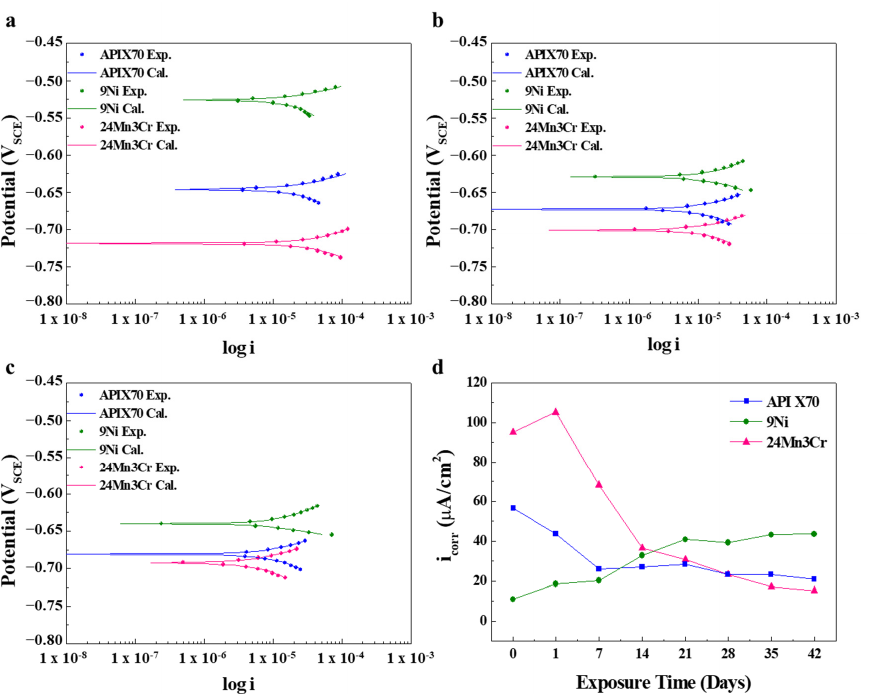
Figure 2. ( a – c ) Curve fitting to the LPR curves of the tested samples with different immersion times: ( a ) 1 h, ( b ) 21 days, and ( c ) 42 days; ( d ) Change in i corr with an increasing immersion time. (Exp. and Cal. are the experimental and fitted data, respectively).